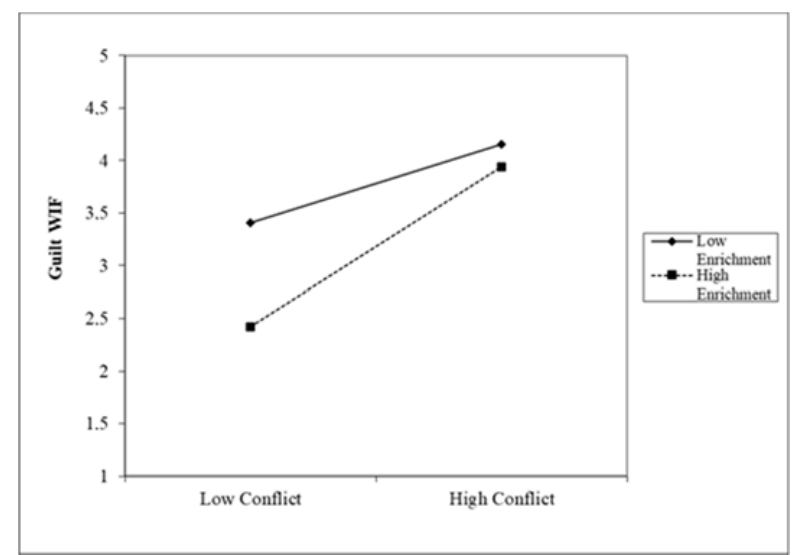
Figure 3. Moderating effect on Guilt WIF